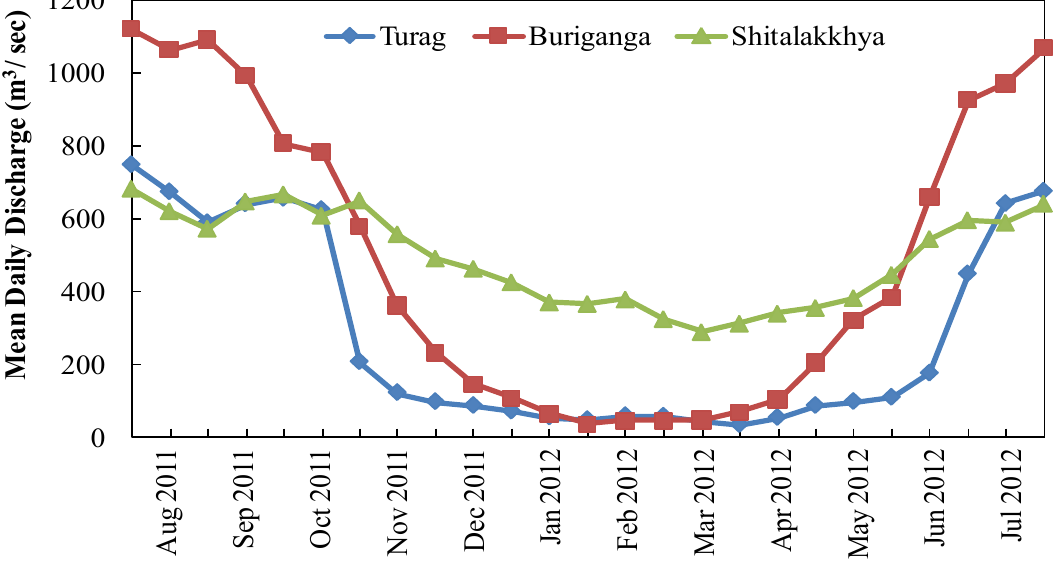
Figure 3. Themean daily discharge (MDD) data of the three main rivers around Dhaka City, Bangladesh. Each of the plots represents a 15-day average MDD